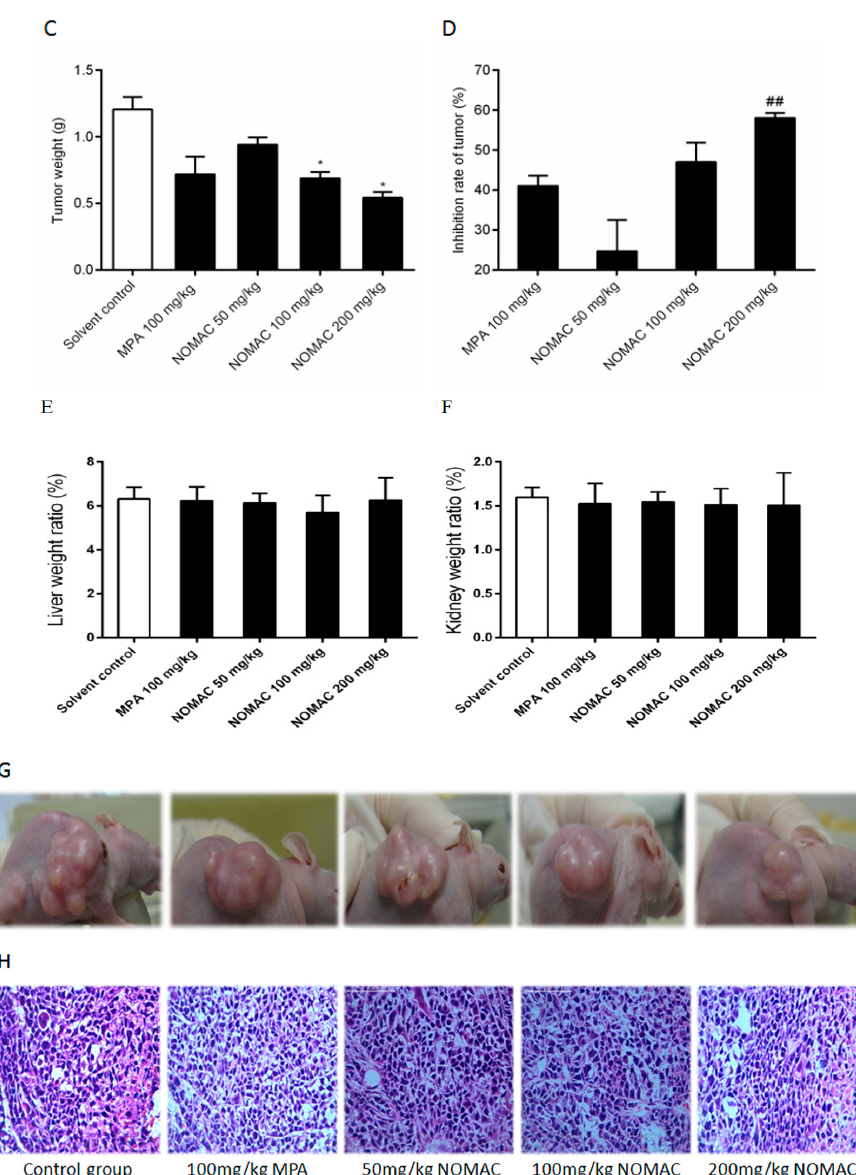
Figure 5. NOMAC and MPA reduced the growth of RL95-2 xenograft tumors in vivo. Mice were treated with 50, 100, and 200 mg/kg NOMAC and 100 mg/kg MPA ( n = 8). ( A ) Body weights of mice before and during the treatment of the tumor xenografts; ( B ) Changes in tumor volume during the treatment; ( C ) Tumor weights in the mice at the end of the treatment; ( D ) The tumor growth inhibition rate. Each point represents the mean ± SD ( n = 8); ( E , F ) Relative liver and kidney weights at the end of the treatment. * p < 0.05 vs. control, ## p < 0.01 vs. the 100 mg/kg MPA group; ( G ) The tumor of RL95-2 xenograft mice at the end of the experiment; ( H ) Hematoxylin and eosin staining of tumor specimens harvested from in vivo experiments (magnification, 400×).